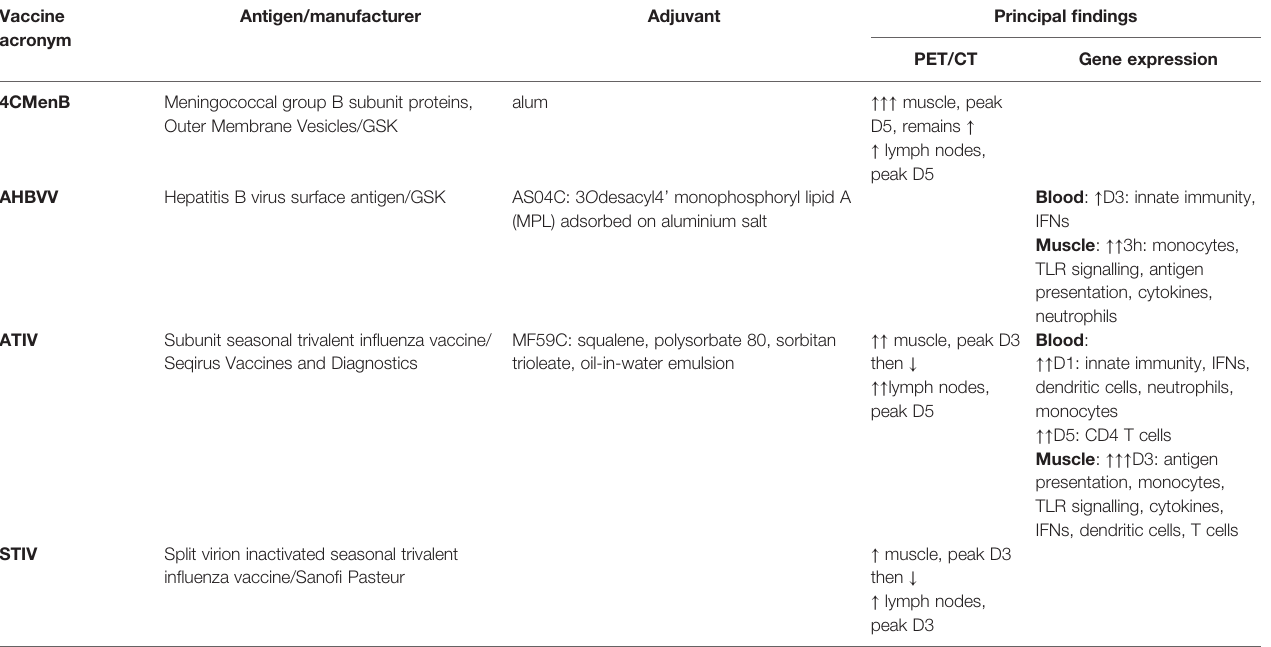
TABLE 1 | Summary of vaccines, antigens, adjuvants and principal fi ndings on PET/CT and Gene Expression. Vaccine acronym